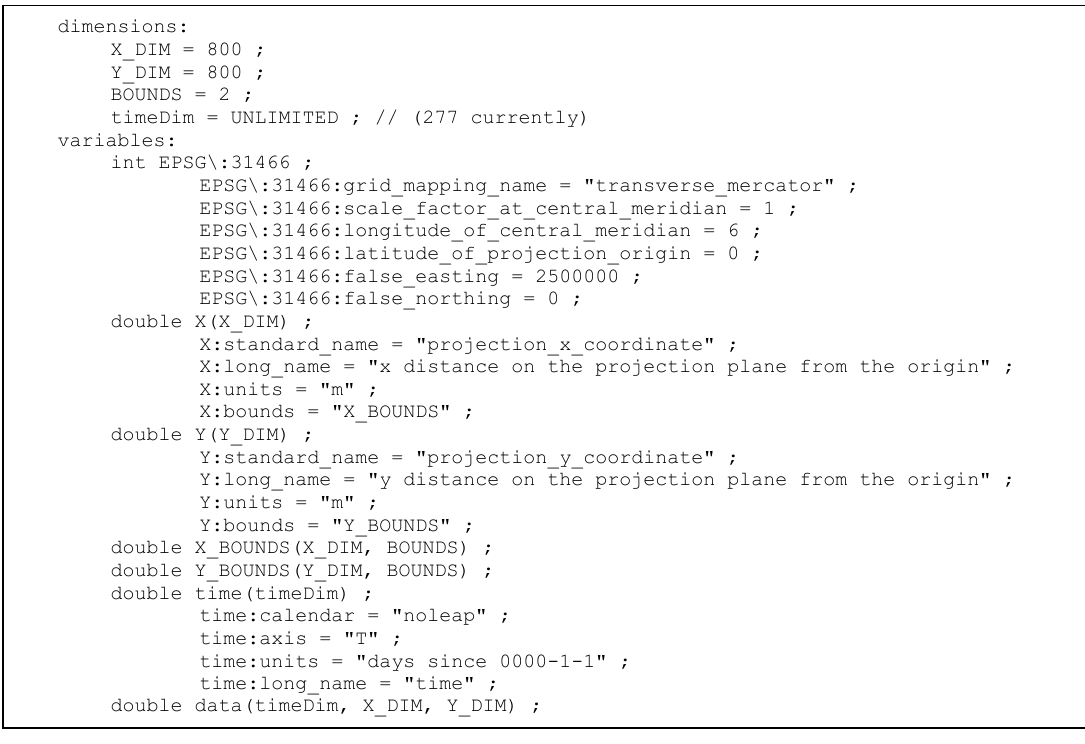
Figure 7. NetCDF file formatted in